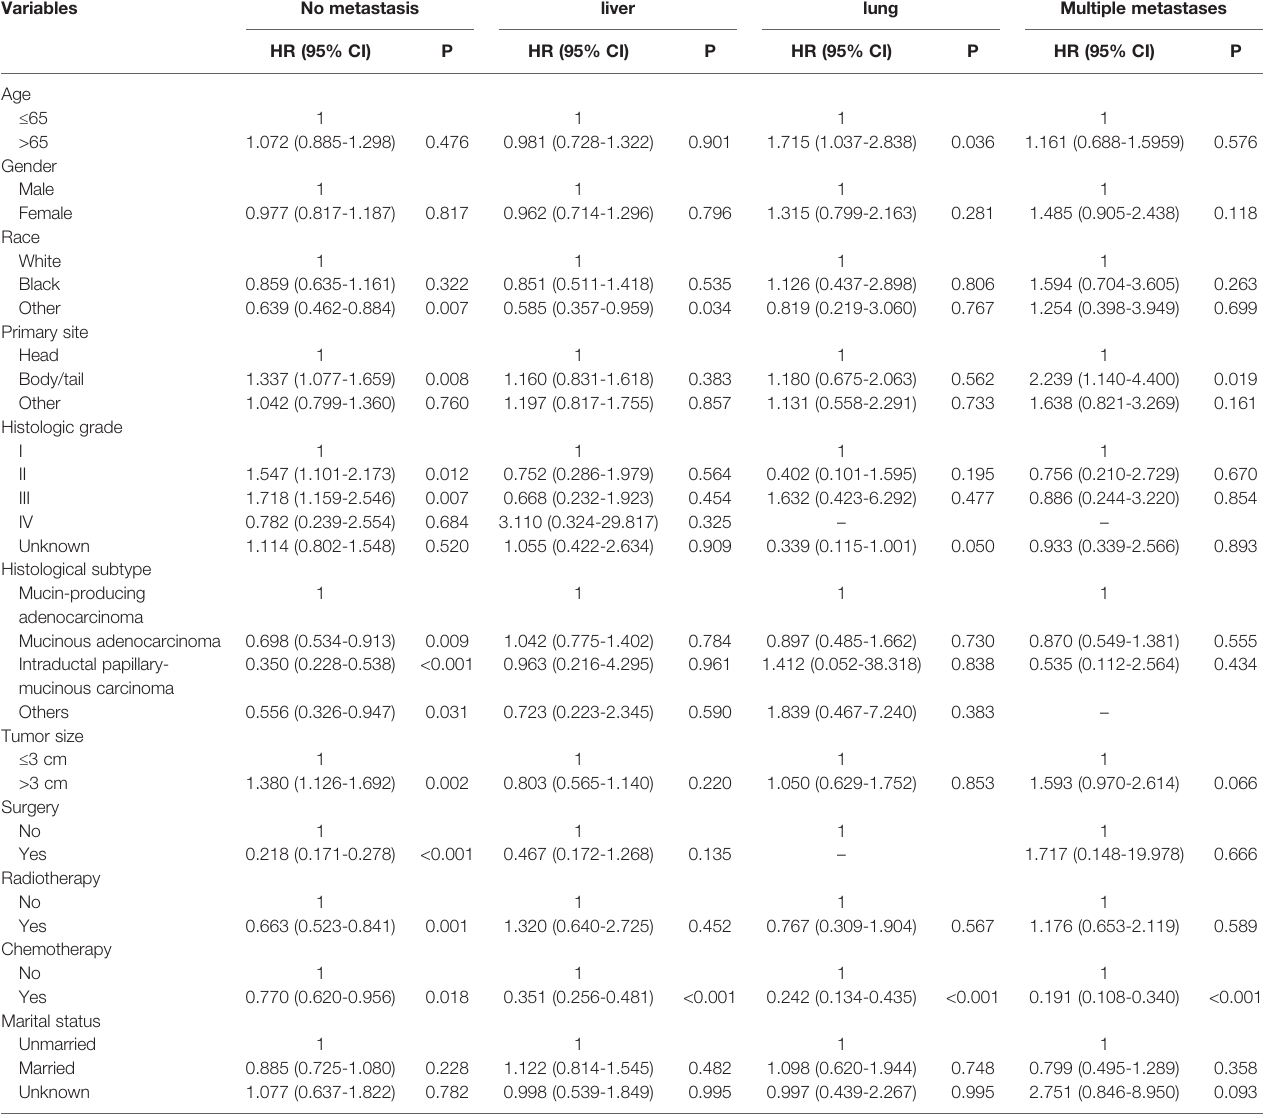
TABLE 3 | Multivariable Cox regression analysis of cancer-speci fi c survival in patient with IPMN with associated invasive carcinoma.